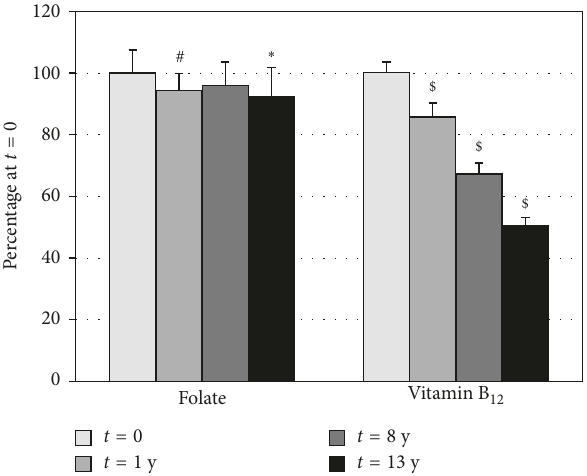
Figure 2: Stability of folate and vitamin B 12 at 1, 8, and 13 years relative to t � 0. The concentrations have been expressed as per- centage of the mean value of their concentrations at t � 0. Statistics: ∗ P < 0 . 05, # P < 0 . 05, and $ P < 0 .